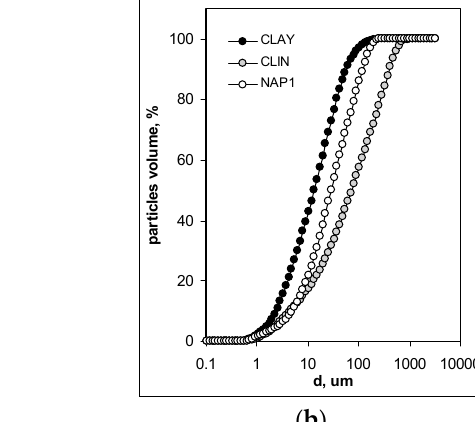
Figure 3. XRD patterns of the lightweight aggregates (LWAs): CLAY ( black ), CLIN ( green ) and NAP1 ( red ).